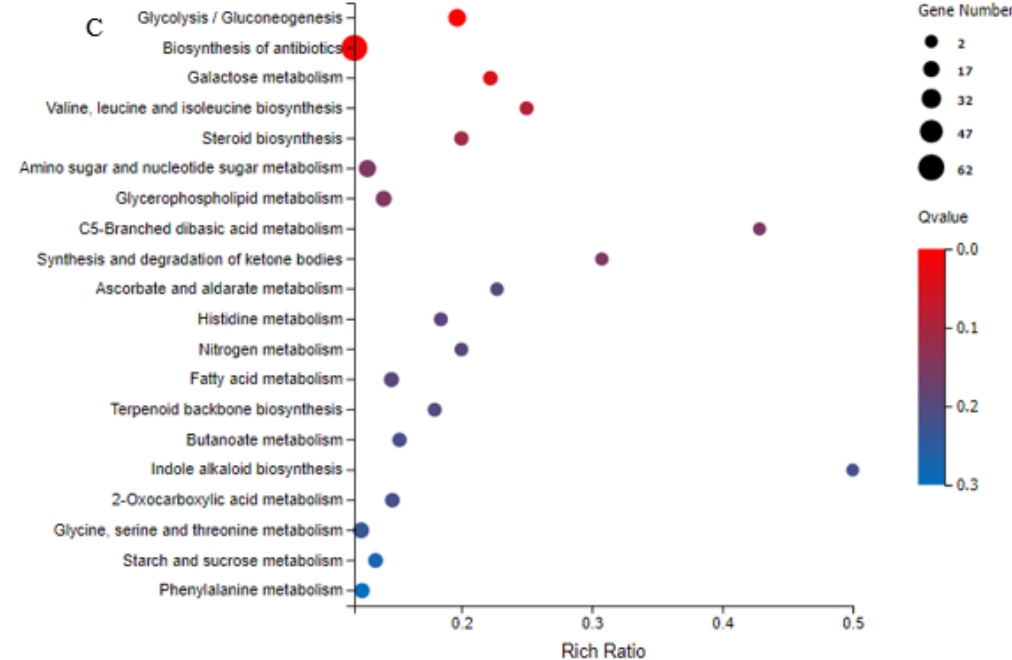
Figure 5. KEGG pathways and their enrichment analyses of DEGs in M. ruber M7 cultivated at 3 and 7 d under 30 mT SMF. ( A ): KEGG pathway of DEGs of CK-3d vs. 30 mT-3d; ( B ): KEGG pathways of DEGs of CK-7d vs. 30 mT-7d; ( C ): KEGG pathway enrichment DEGs of CK-3d vs. 30 mT-3d. The enrichment ratio indicates the number of DEGs relative to the percentage of all annotated genes involved in the pathway.